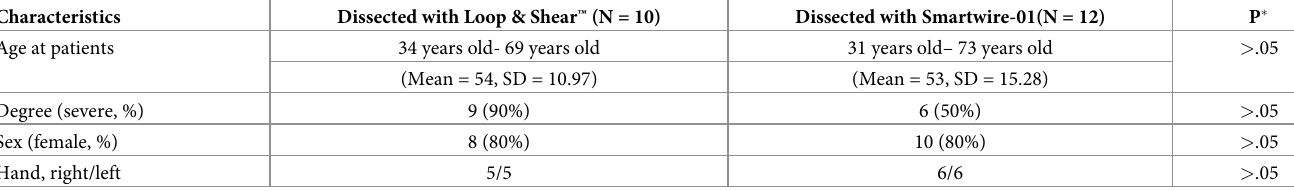
Table 1. General characteristics of